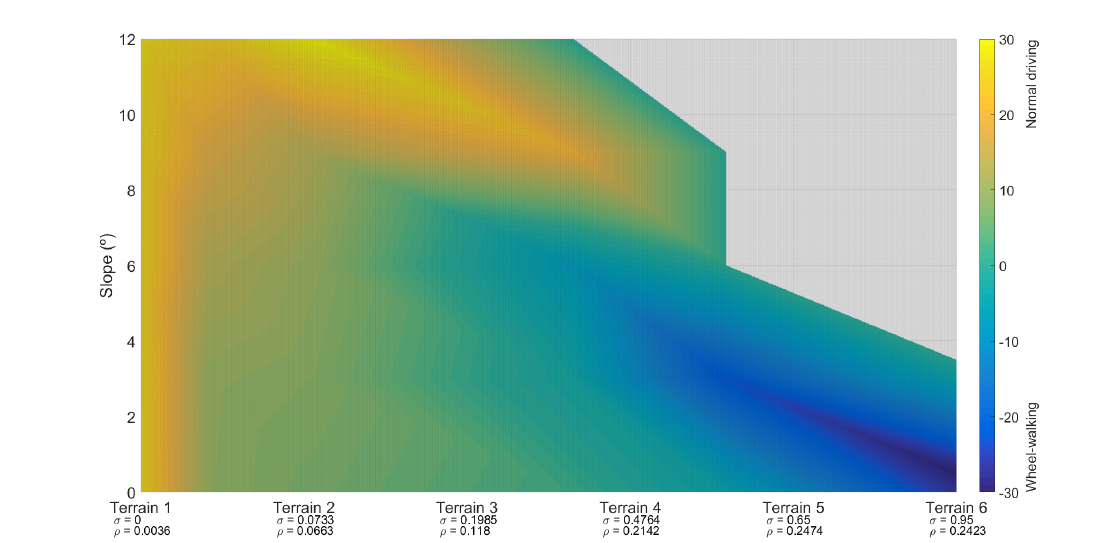
Figure 12. Best locomotion mode in function of slope and terrain. This figure shows how normal driving is the best one in most of cases, and wheel walking is suitable for terrains with σ ≥ 0.47, ρ ≥ 0.21. It is worth mentioning that grey area in the figure represents terrains and slopes that cannot be overcome by the rover due to the terrain parameters and the